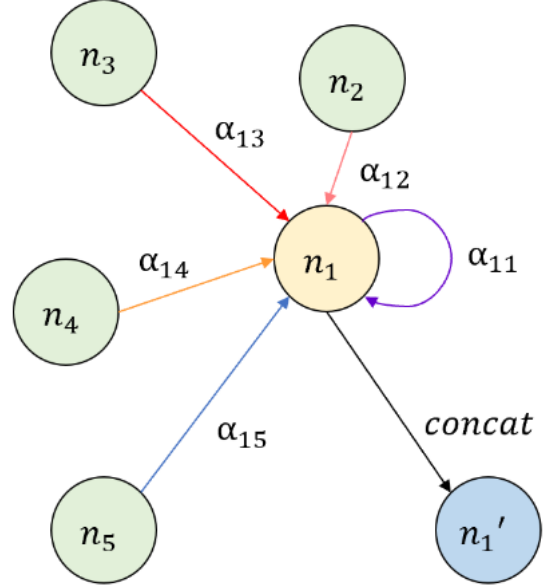
Figure 3. Attention mechanism of GAT.